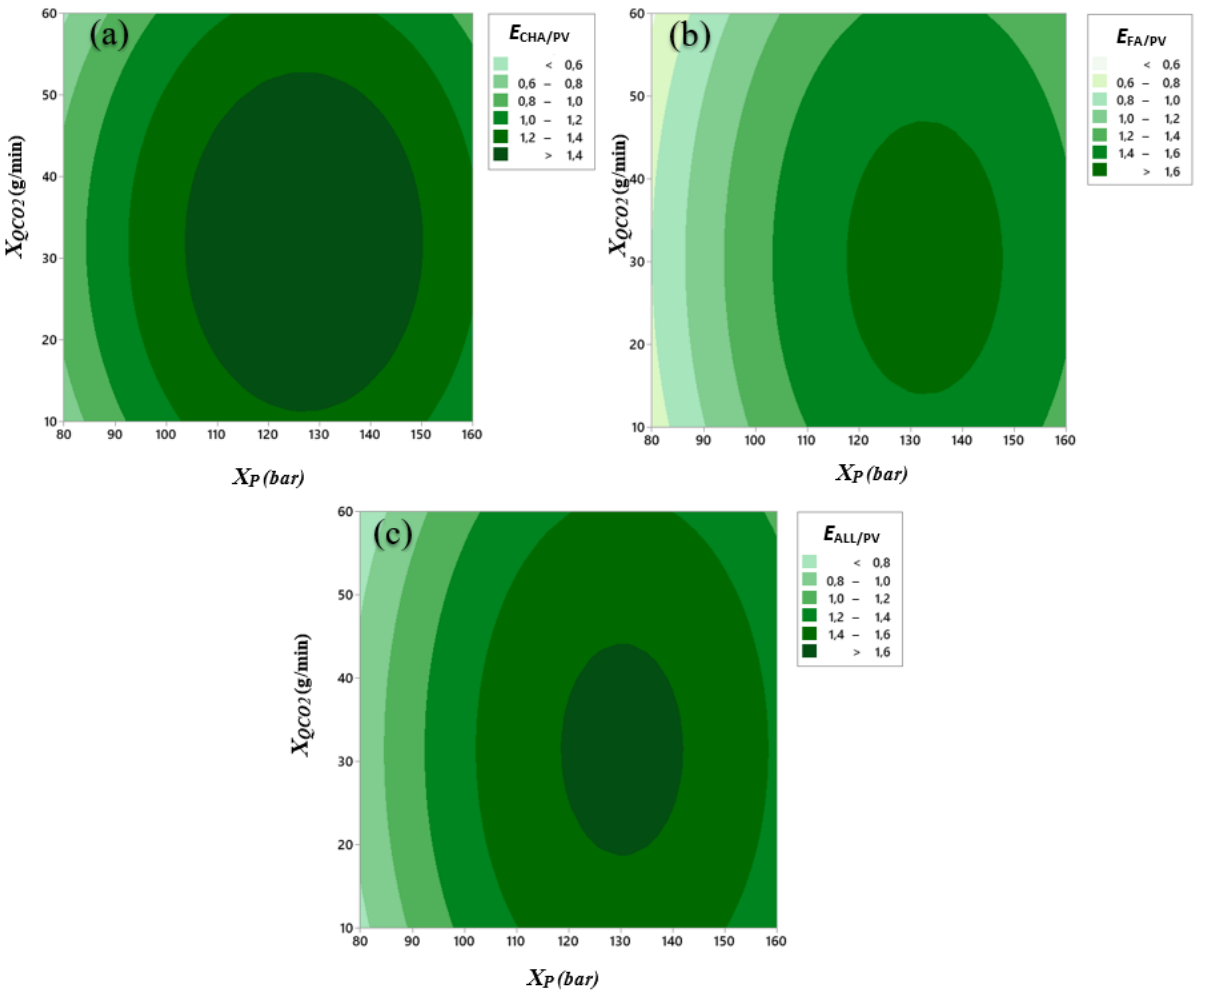
Figure 5. Contour plots of the enrichment ratios: ( a ) E CHA/PV ; ( b ) E FA/PV , and ( c ) E ALL/PV as a function of pressure, X P (bar), and CO 2 flow rate, X QCO2 (g/min).